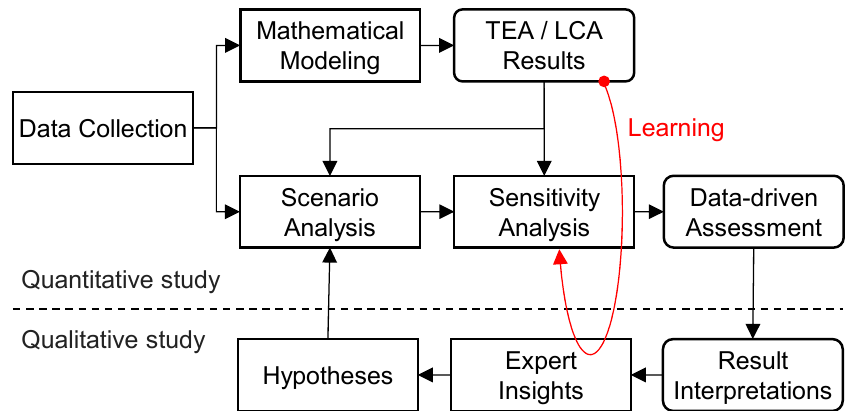
Figure 4. Multi-objective impacts assessment method.